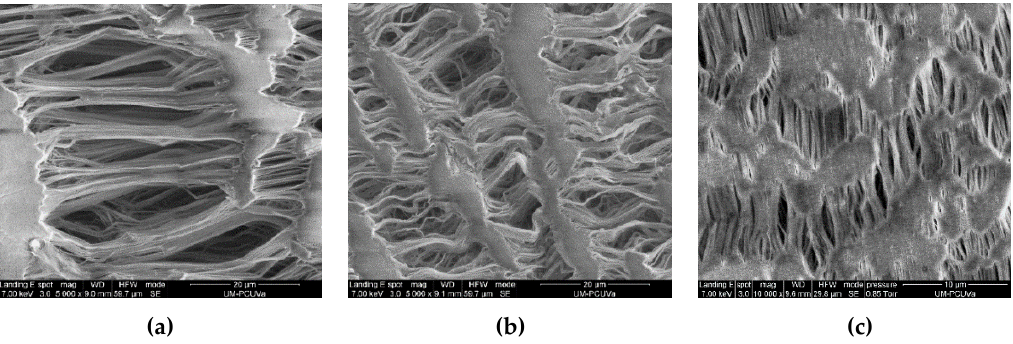
Figure 2. Scanning electron microscopy (SEM) images for the ZM ( a ), PM ( b ), and FZM ( c ) ePTFE membranes showing typical elongated pores of di ff erent sizes structures. The images correspond to the inner surface of the tubular membranes. Images A and B were taken with 5000 × magnification and the scale bar is equivalent to 20 µ m in length. Image C were taken with 10,000 × magnification and the scale bar is equivalent to 10 μm in length.